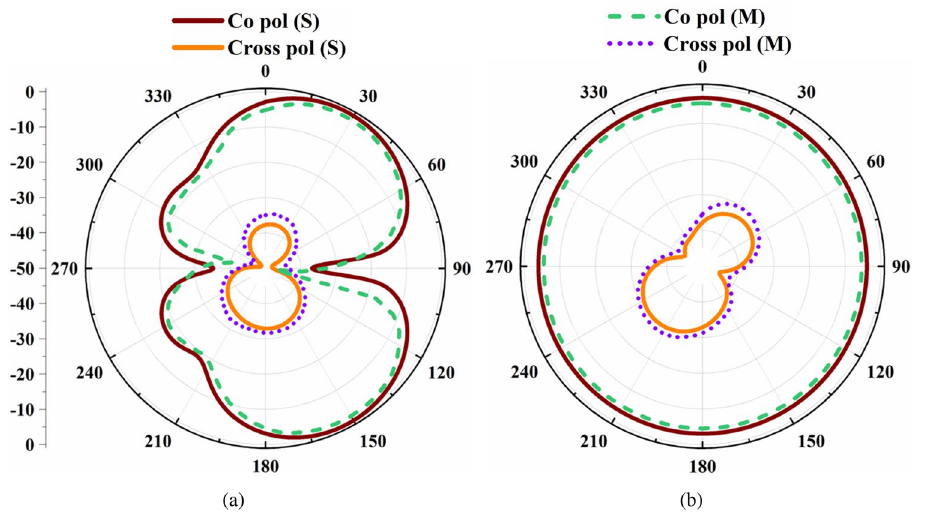
Figure 10. The simulated and measured radiation pattern of the FBCA at 2.45 GHz in ( a ) phi = 0 ◦ , ( b ) phi = 90 ◦